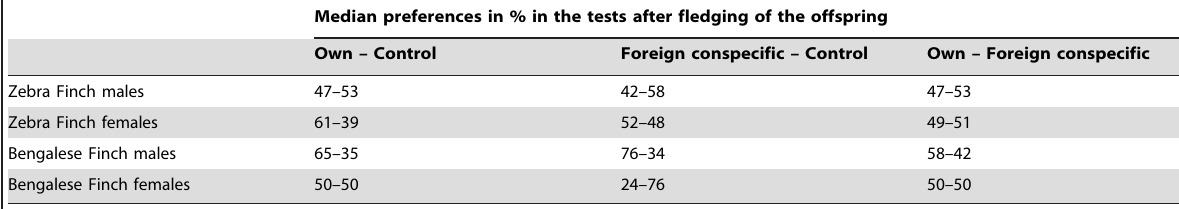
Table 2. Results of the odour preference tests of zebra finches and Bengalese finches parents after fledging of the offspring.